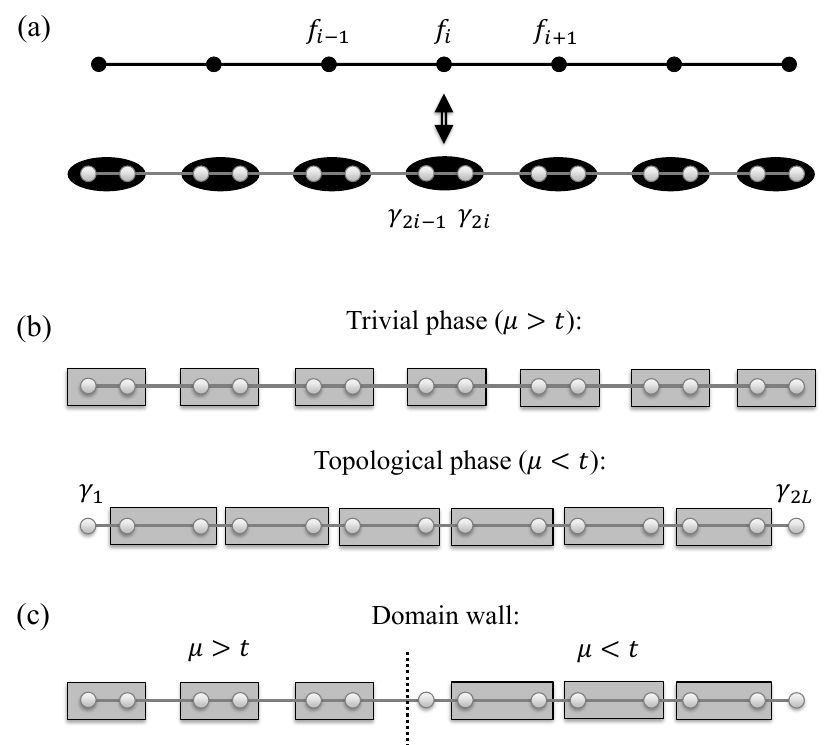
Figure 9: Kitaev’s toy model for a p -wave paired superconducting wire [ 63 ] . (a) The original Hamiltonian (29) in terms of complex fermions f is defined on a one-dimensional lattice of j L sites. When each complex fermion operator is decomposed into two Majoranas by writing = e − i θ/ 2 ( γ + i γ ) / 2, the Hamiltonian (30) describes free Majorana fermions on a f j 2 j − 1 2 j